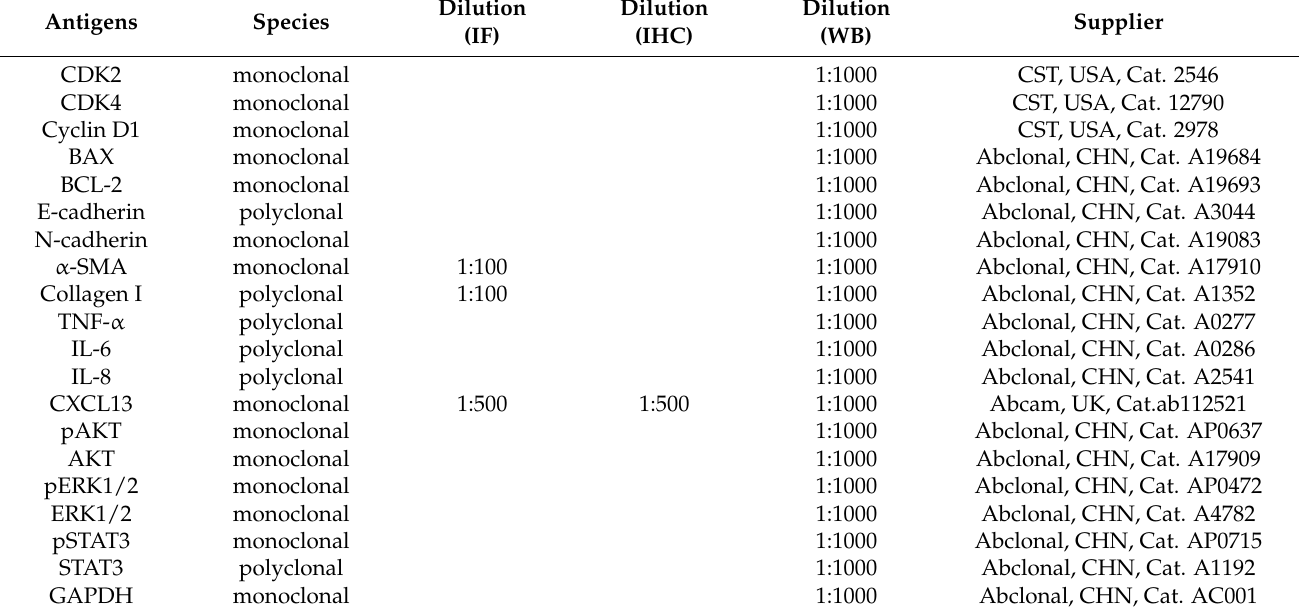
Table 5. List of primary antibodies (All antibodies we used are rabbit